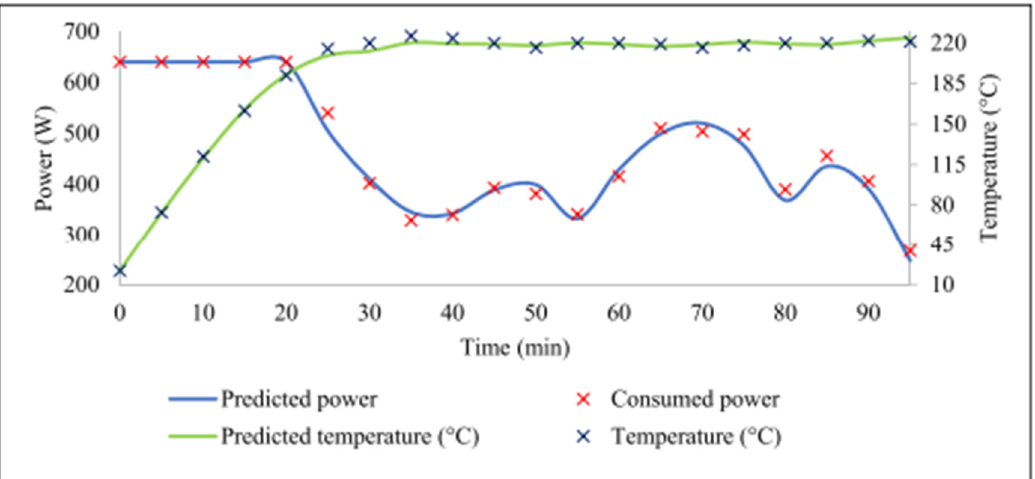
Figure 5. Predicted and actual consumed power from computational and experimental model by Heidari et al. [12].